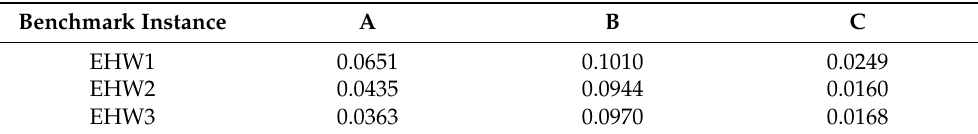
Table 11. Comparation of selected values—evolutionary and metaheuristic method for benchmark Table 14. Coefficient of